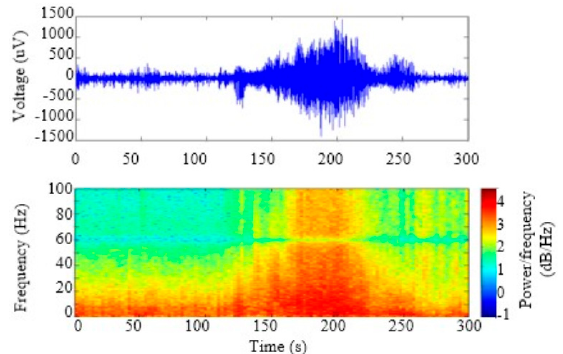
Figure 9. One recorded ictal EEG data and its spectrogram.